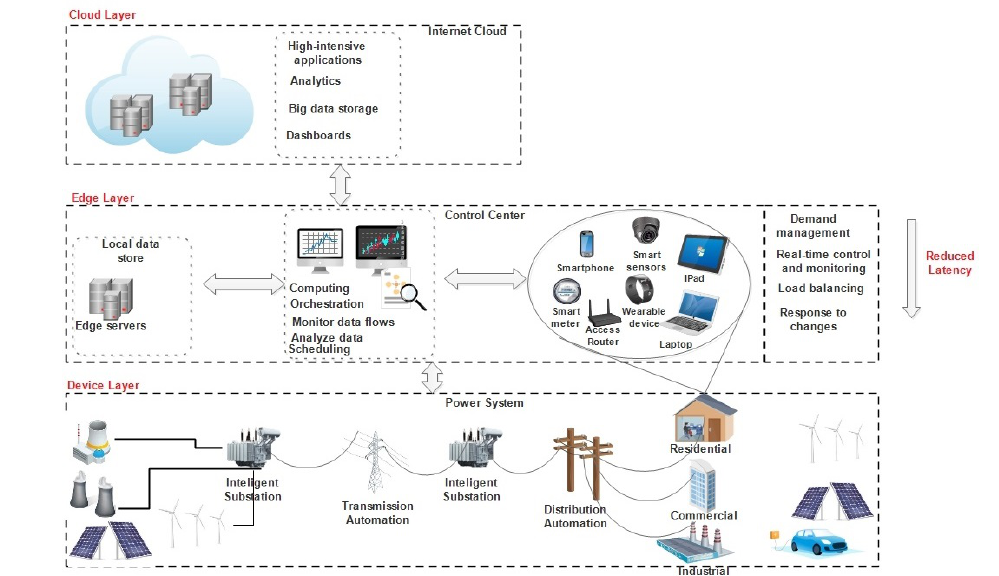
Figure 5. Generic edge computing architecture for smart